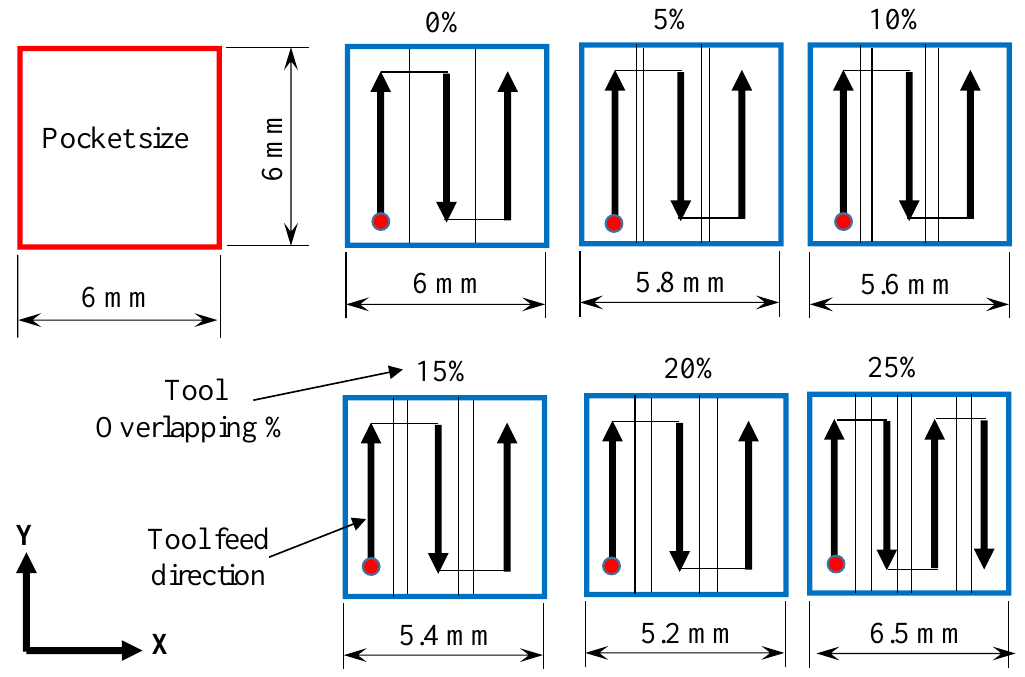
Figure 3. Schematic of tool overlapping (0%–25%).